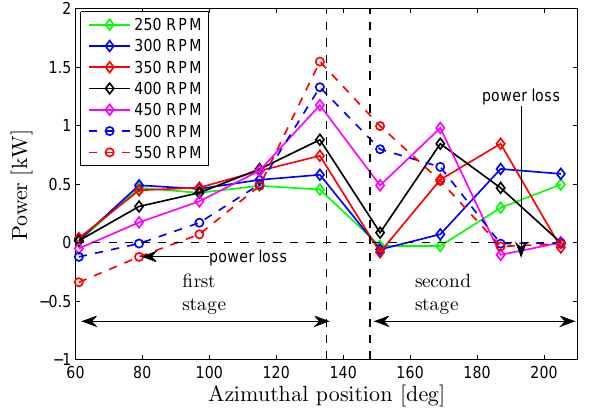
Figure 7. Azimuthal variation of power extraction per blade in the 7 kW turbine at η max and ω max = 450 RPM ( Q = 105 lps and H = 10 m)